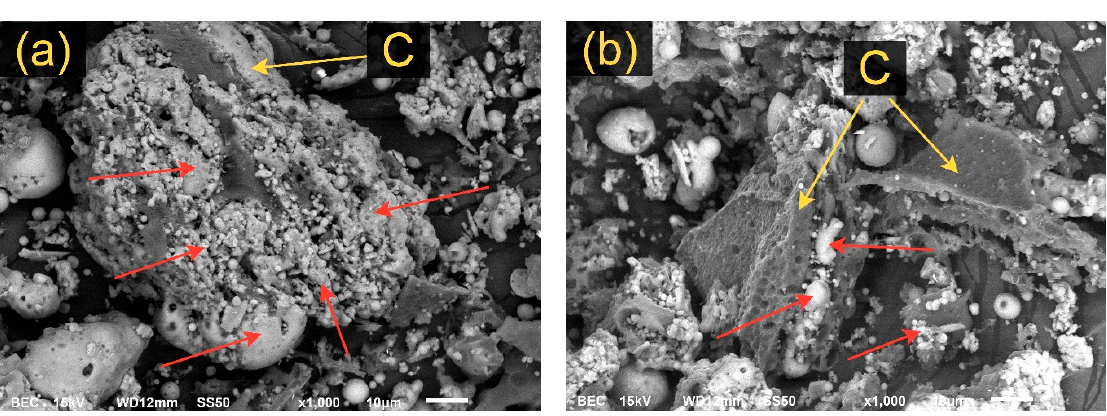
Figure 9. The effect of particle size and flotation time on the unburned carbon recovery.